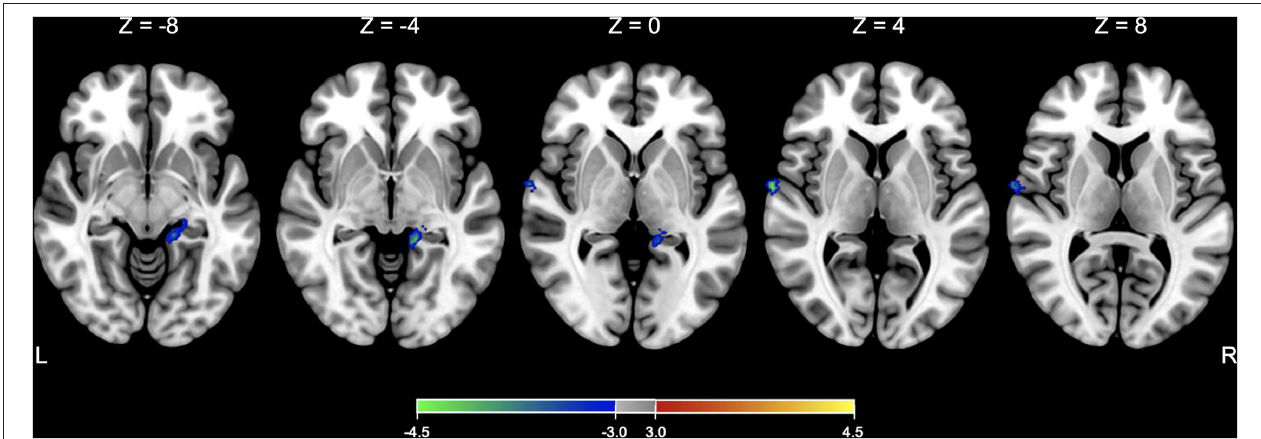
FIGURE 3 | SPECT analysis results. Significant areas with treatment (active vs. sham) x time (baseline vs. immediate follow-up) interaction effects of rCBF are overlaid on the Montreal Neurological Institute (MNI) 152 template. Color bar represents the voxel-level t -values.